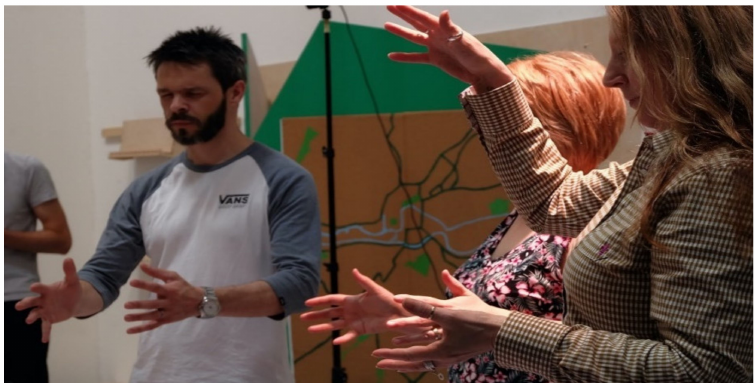
Figure 6. TFS workshops, task 6—Knowle West Media Centre,